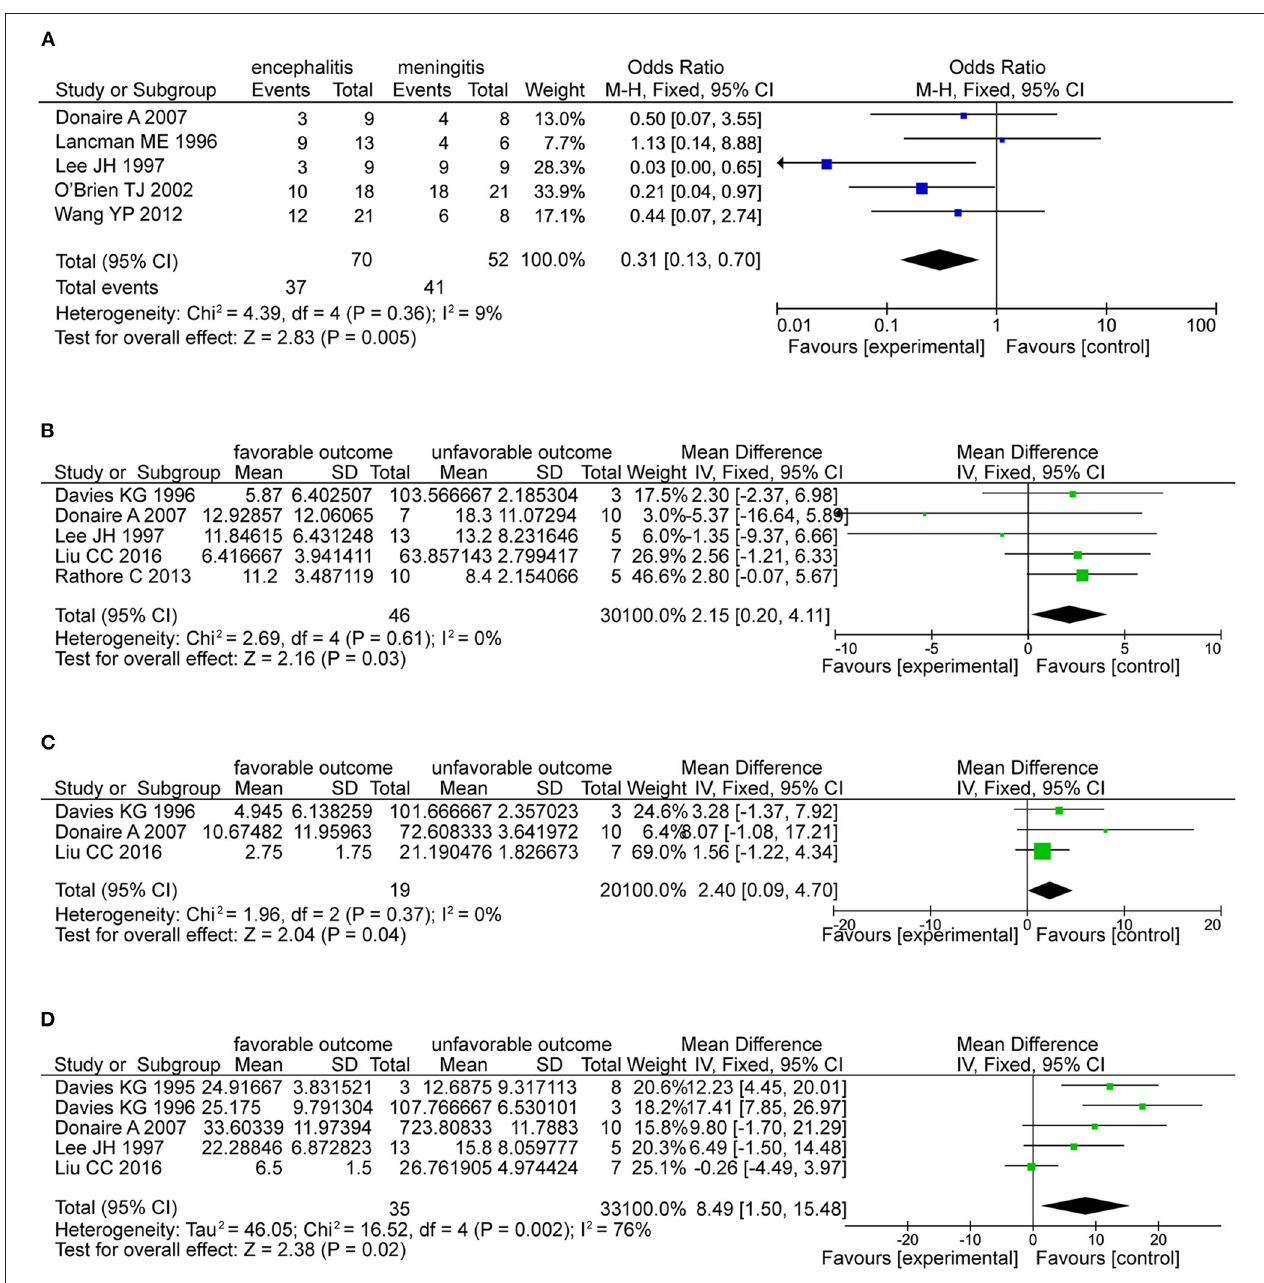
FIGURE 2 | The factors associated with favorable outcomes. (A) The forest plot showed that meningitis was associated with favorable outcomes than encephalitis (OR 0.31, 95% CI 0.13–0.70, P = 0.005). (B) The forest plot showed older age at epilepsy (OR 2.15, 95% CI 0.20-4.11, P = 0.03) is associated with favorable outcomes. (C) Forest plot showed longer silent period (OR 2.40, 95% CI 0.09-4.70, P = 0.04) is associated with favorable outcomes. (D) Forest plot showed the time from infection (OR 8.49, 95% CI 1.50-15.48, P = 0.02) is associated with favorable